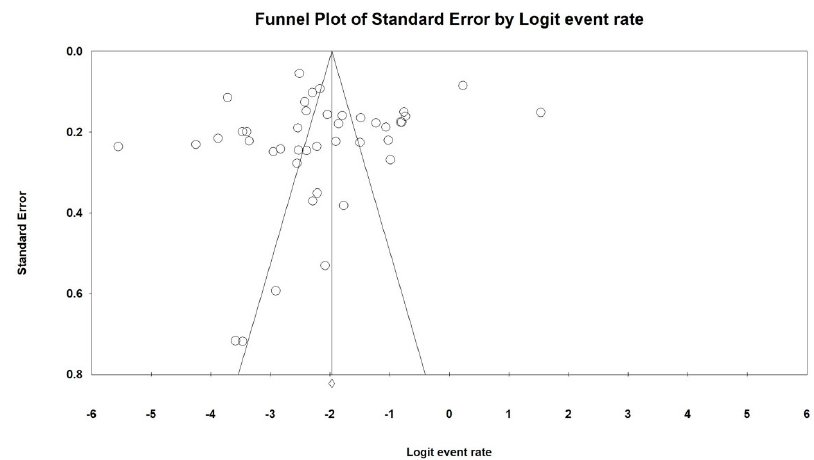
Figure 3. Funnel plot of publication bias on prevalence of VTE in ICU patients.